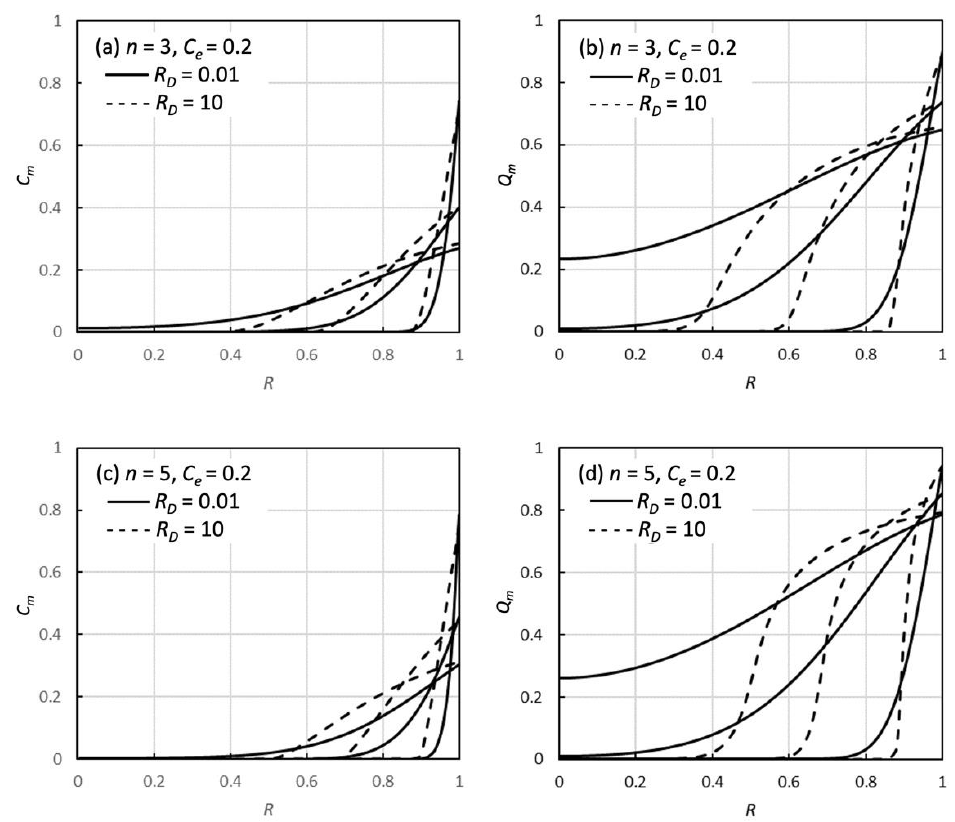
Figure 2. Distribution of adsorbate in the adsorbent particles. ( a ) C m , n = 3, ( b ) Q m , n = 3, ( c ) C m , n = 5, ( d ) Q m , n = 5. The bold lines indicate the distribution in the case of R D = 0.01 at T = 4 × 10 − 3 , 4 × 10 − 2 and 1 × 10 − 1 , respectively. The dotted lines indicate the distribution in the case of R D = 10 at T = 4 × 10 − 4 , 4 × 10 − 3 and 1 × 10 − 2 .